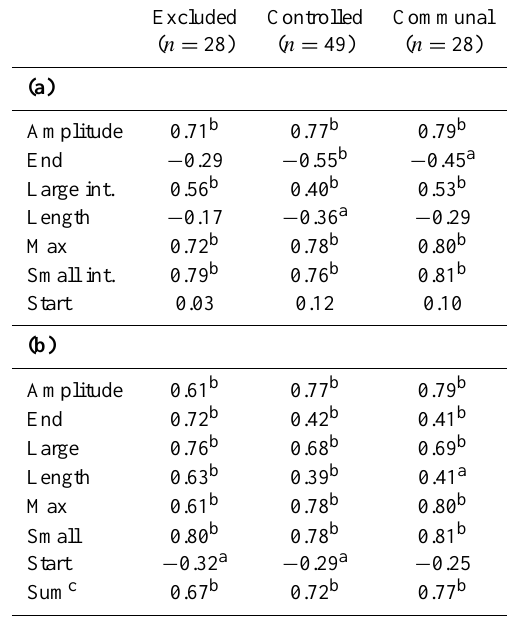
Table 4. Correlation coefficients between in situ measurements of biomass and satellite-based growing season metrics derived from MODIS NDVI product with: (a) relative amplitude dependent thresholds. (b) Thresholds set to absolute